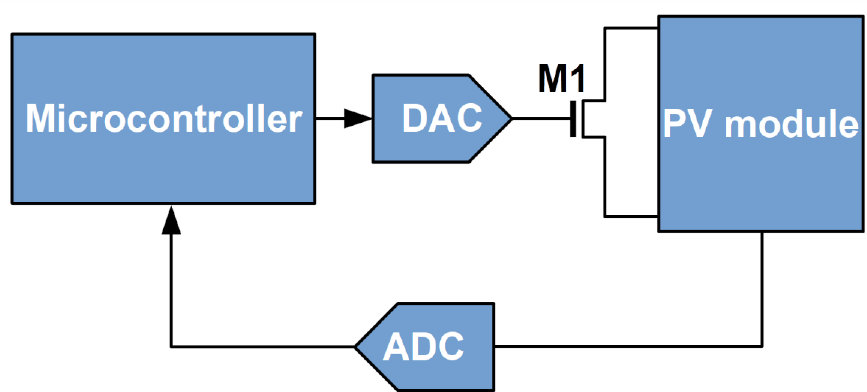
Figure 3. Schematic of the sweeping closed control loop.